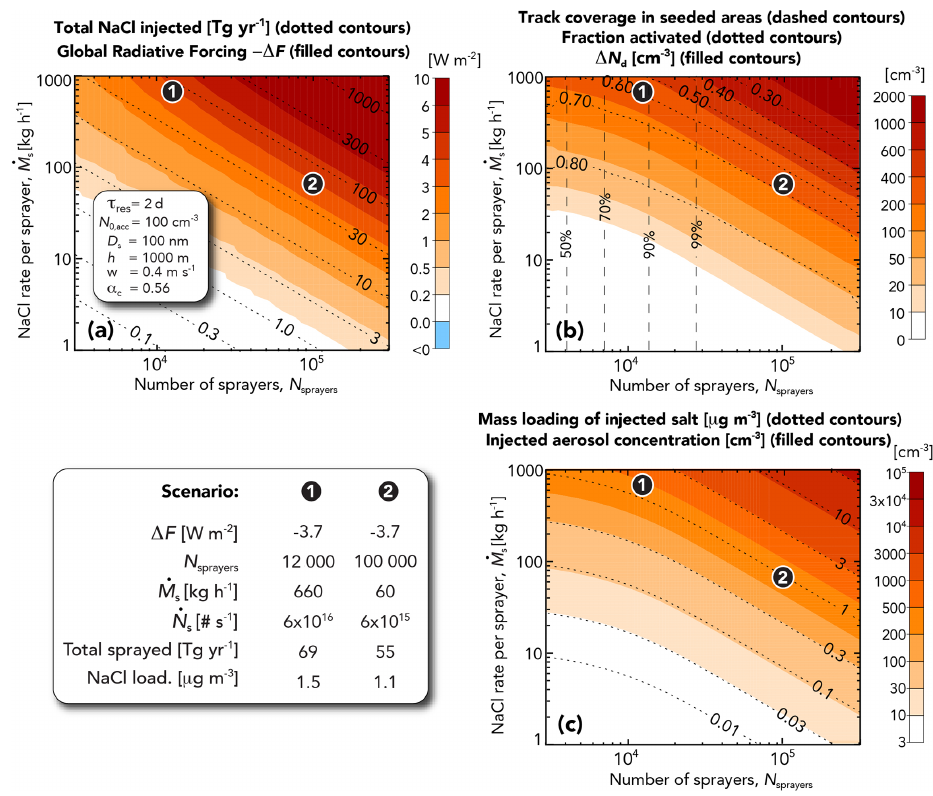
Figure 5. (a) Global mean radiative forcing (cid:49)F (colors) and total flux of sodium chloride (dotted contours) from MCB applied to all eligible ocean areas (54% of Earth’s surface) as a function of the number of sprayers N sprayers and the salt mass injection rate ˙ M s for each sprayer. (b) Increase in cloud droplet concentration (cid:49)N d (colors), mean fraction of aerosol activated in tracks (dotted contours), and track coverage (dashed contours). (c) Injected aerosol number concentration in tracks (colors) and mean mass loading in the MBL of injected salt (dotted contours). The inset of panel (a) shows the key model parameters, with others as seen in Table 1. The two scenarios, (1) and (2), which each produce sufficient forcing to offset doubled CO 2 , are highlighted. Scenario (2) has a higher number of sprayers but a lower rate of particles injected per